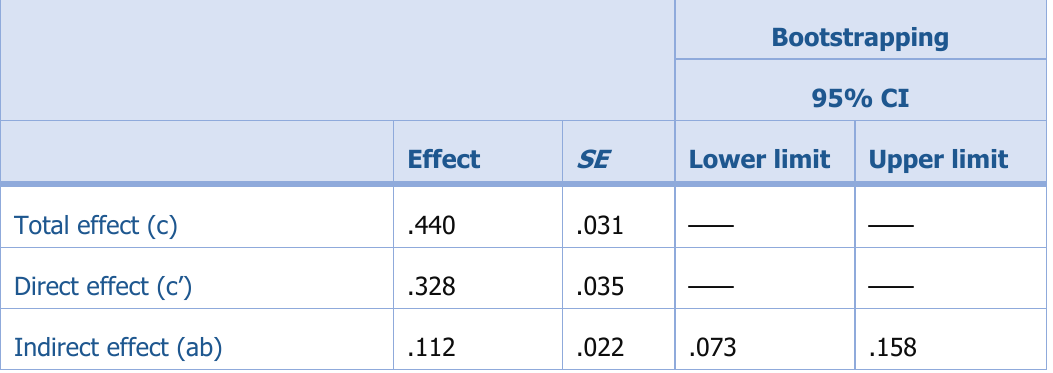
Table 2. Total Effects, Direct Effects, and Bootstrap Analysis of Indirect Effect for the Association of Environmental Awareness with Self-Concept Mediated by Social